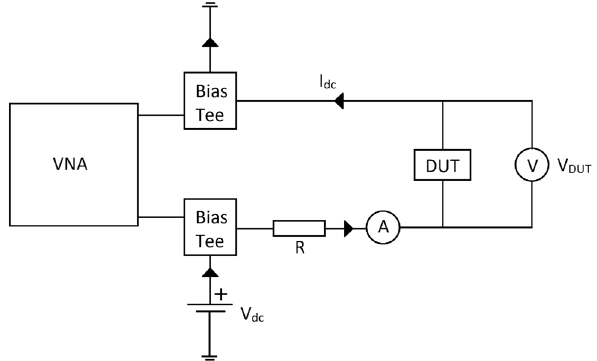
Figure 5. Measurement set-up consisting of a VNA, bias tees, protection resistor, ammeter, voltmeter, and